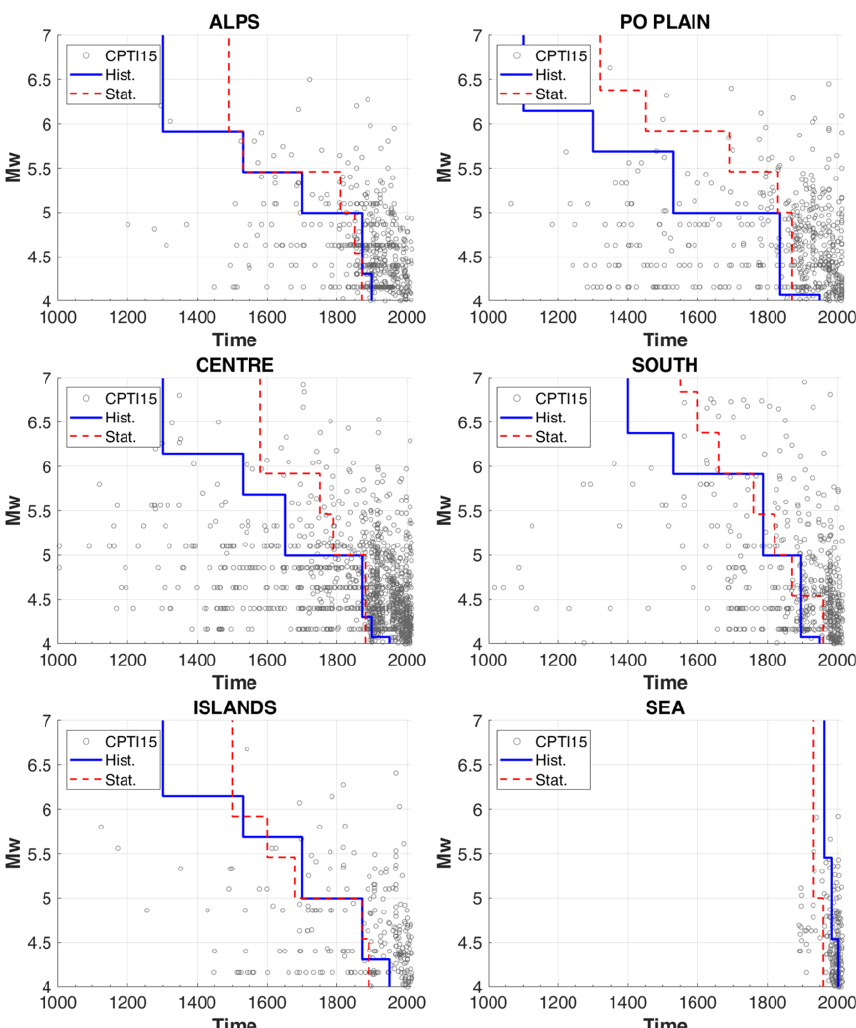
Figure 6. Plot of time vs. completeness magnitude, defined according to both the historical and statistical approach, in the six macroareas shown in Fig. 5a. Grey circles represent the earthquakes in CPTI15. Hist: historical approach, Stat: statistical